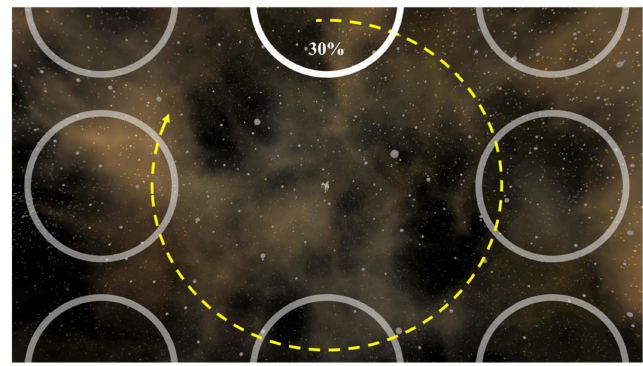
Figure 3. The third VR sickness reduction method (M3). The VG of the fourth VR sickness reduction method had a size 30% that of the aspect ratio, and a position that moves CCW every second along the eight points. This